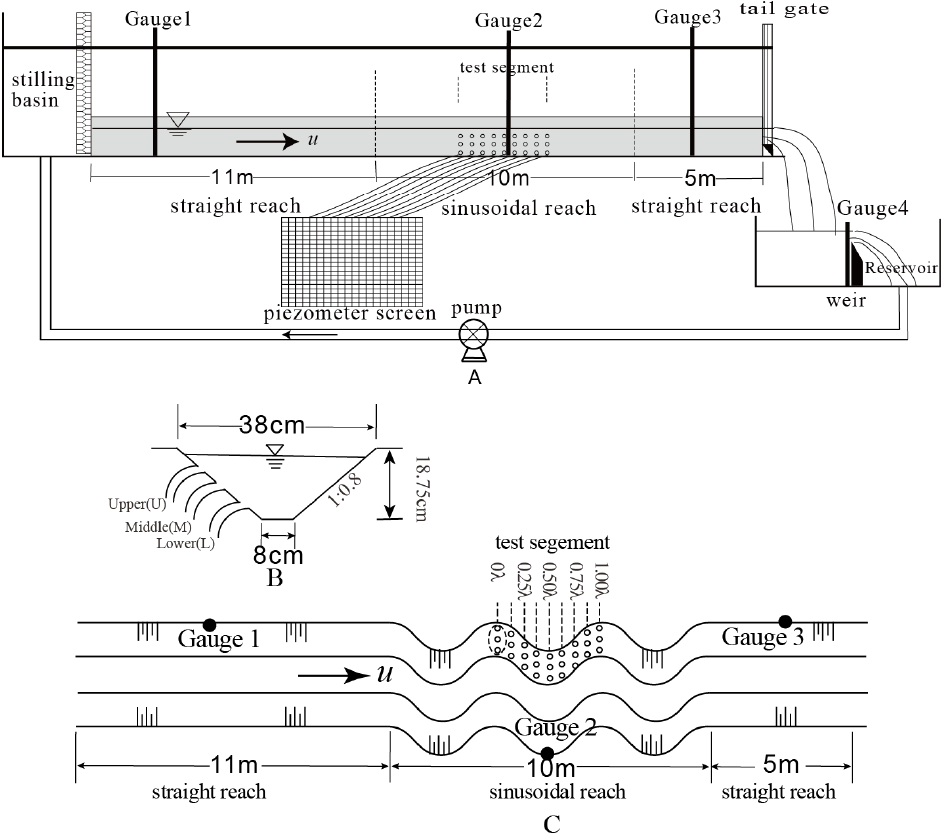
Figure 1. Schematic diagram of experimental setups. ( A ) is the view of the laboratory flume and measurement setups. ( B ) is the cross section of channel module; ( C ) is the top view of the sinusoidal river and test sections.